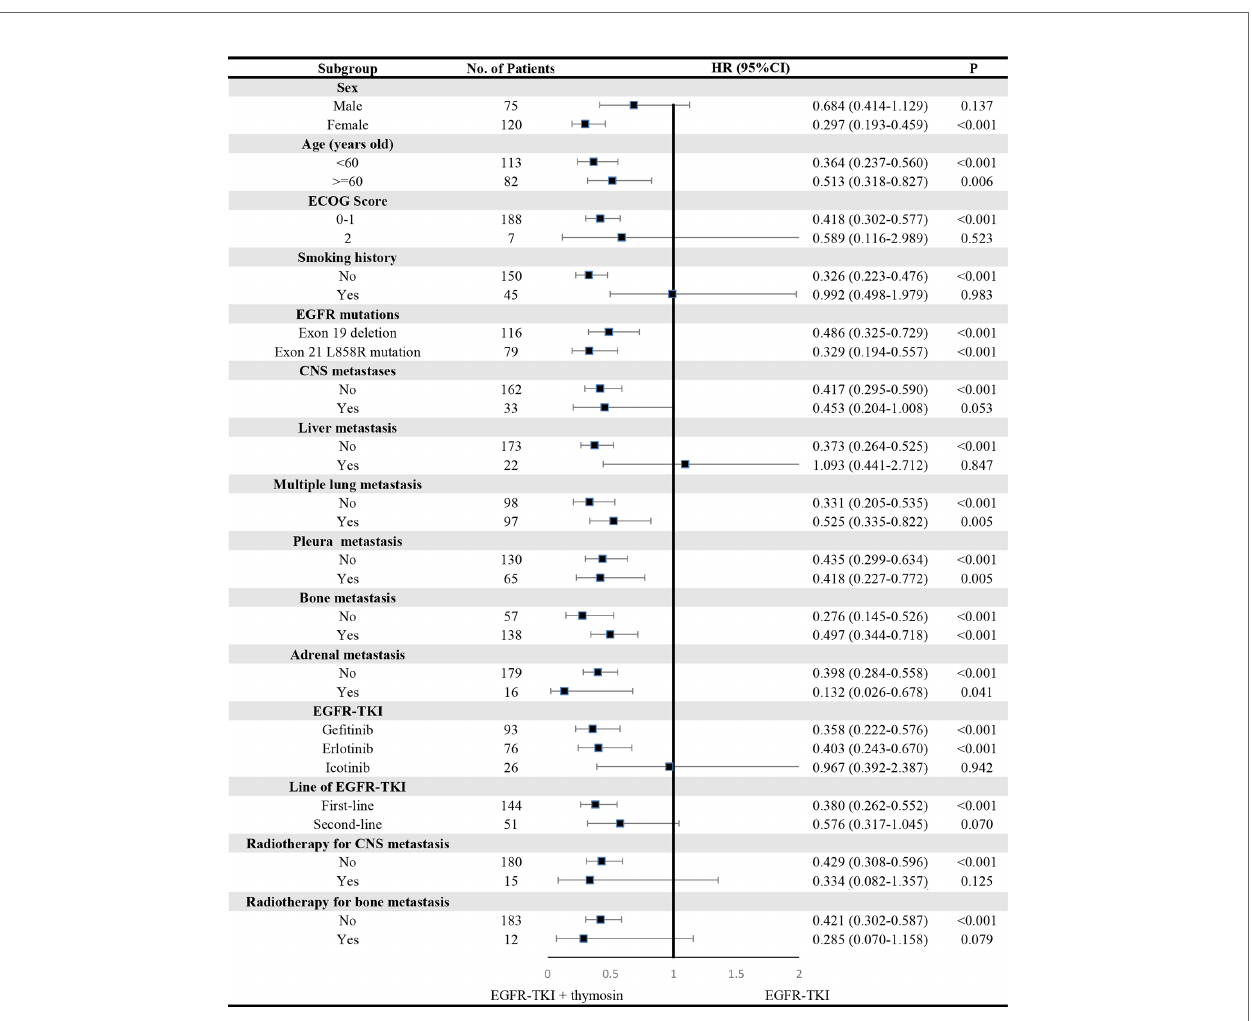
FIGURE 2 | Subgroup Analyses of Progression-free Survival. P showed the signi fi cance of the HRs. It was used to test the signi fi cance of PFS between EGFR-TKI plus thymosin group and EGFR-TKI group in a certain variable. HR, hazard ratio; CI, con fi dence interval; ECOG, eastern cooperative oncology group; CNS, central nervous ( Figure 4D ). In the EGFR-TKI plus thymosin group, both the number of CD3 + T cells and the ratio of CD3 + CD4 + T to